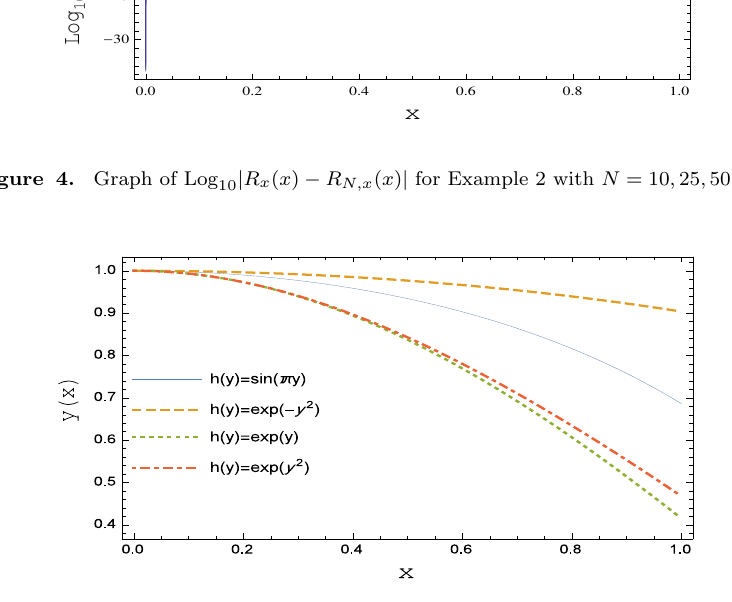
Table 2. Integrals of the squared residual errors for Example 2 with m=10 iterations, N = 10 , 25 , 50 and various nonlinearity . h ( y ) N=10 N=25 N=50 y 5 . 20584 × 10 − 4 2 . 51154 × 10 − 5 1 . 63545 × 10 − 6 − y 2 9 . 13069 × 10 − 6